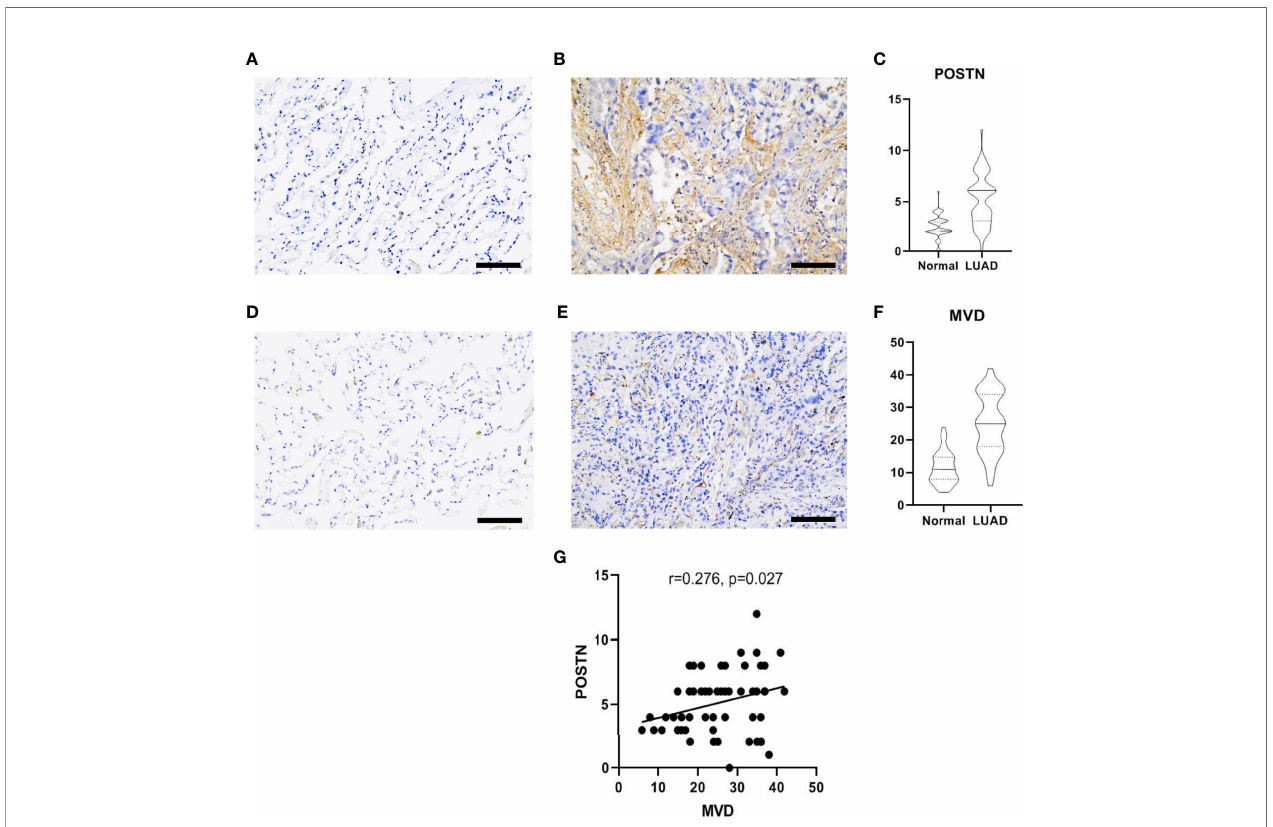
FIGURE 3 | Immunohistochemical staining of lung adenocarcinoma (LUAD) specimens. (A) Immunostaining images of POSTN in the adjacent normal tissues. Scale bar = 100 m m. (B) The distribution of POSTN in the LUAD tumor tissues in interstitial cells was denser than that in cancer cells. Scale bar = 100 m m. (C) The expression of POSTN in tumor tissues was higher than that in the adjacent normal tissues ( p < 0.0001). (D) Immunohistochemical staining of CD34, which was used to mark endothelial cells and to count microvessel density (MVD) in the adjacent normal tissues. Scale bar = 100 m m. (E) Distribution of CD34 in the LUAD tumor tissues. Scale bar = 100 m m. (F) The expression of MVD in the LUAD tissues was higher than that in the adjacent normal tissues ( p < 0.0001). (G) The correlation analyses revealed that the POSTN expression was positively correlated with MVD in lung